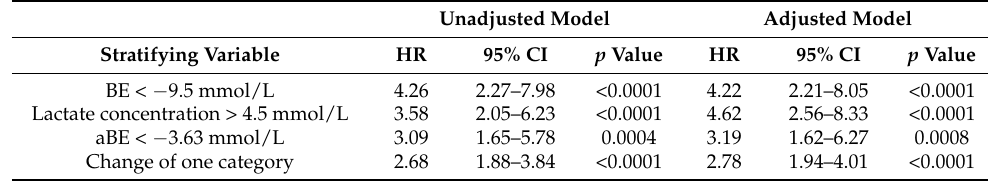
Table 3. Results of unadjusted and adjusted Cox proportional hazards regression models for the 28-day ICU mortality in patients with shock. Adjustments were made according to patients’ age, gender, presence of severe renal failure (eGFR < 30 mL/min/1.73 m 2 ), and type of shock.